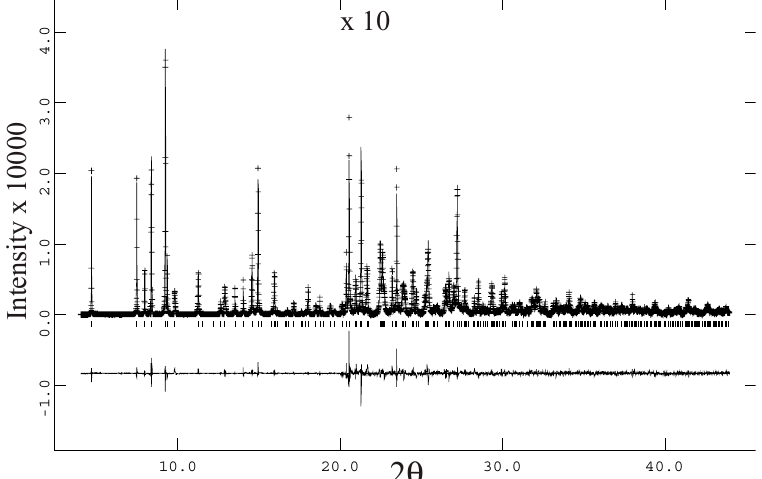
Figure 2. The HRPXRD trace for hausmannite sample-b together with the calculated (continuous line) and observed (crosses) profiles. The di ff erence curve ( I obs – I calc ) with the same intensity scale is shown at the bottom of the trace. Short vertical lines indicate allowed reflection positions. The intensities for the trace and di ff erence curve that are above 20 ◦ 2 θ are multiplied by